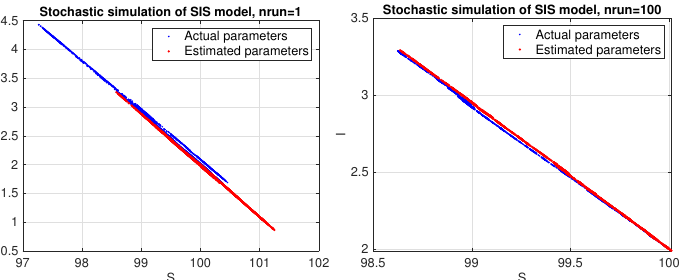
Figure 3. SIS model. Phase space corresponding to a stochastic simulation using the estimated parameters (red color) compared to the actual ones (blue color). Results are shown for a single trial ( left panel ) and average over 100 trials ( right panel ).